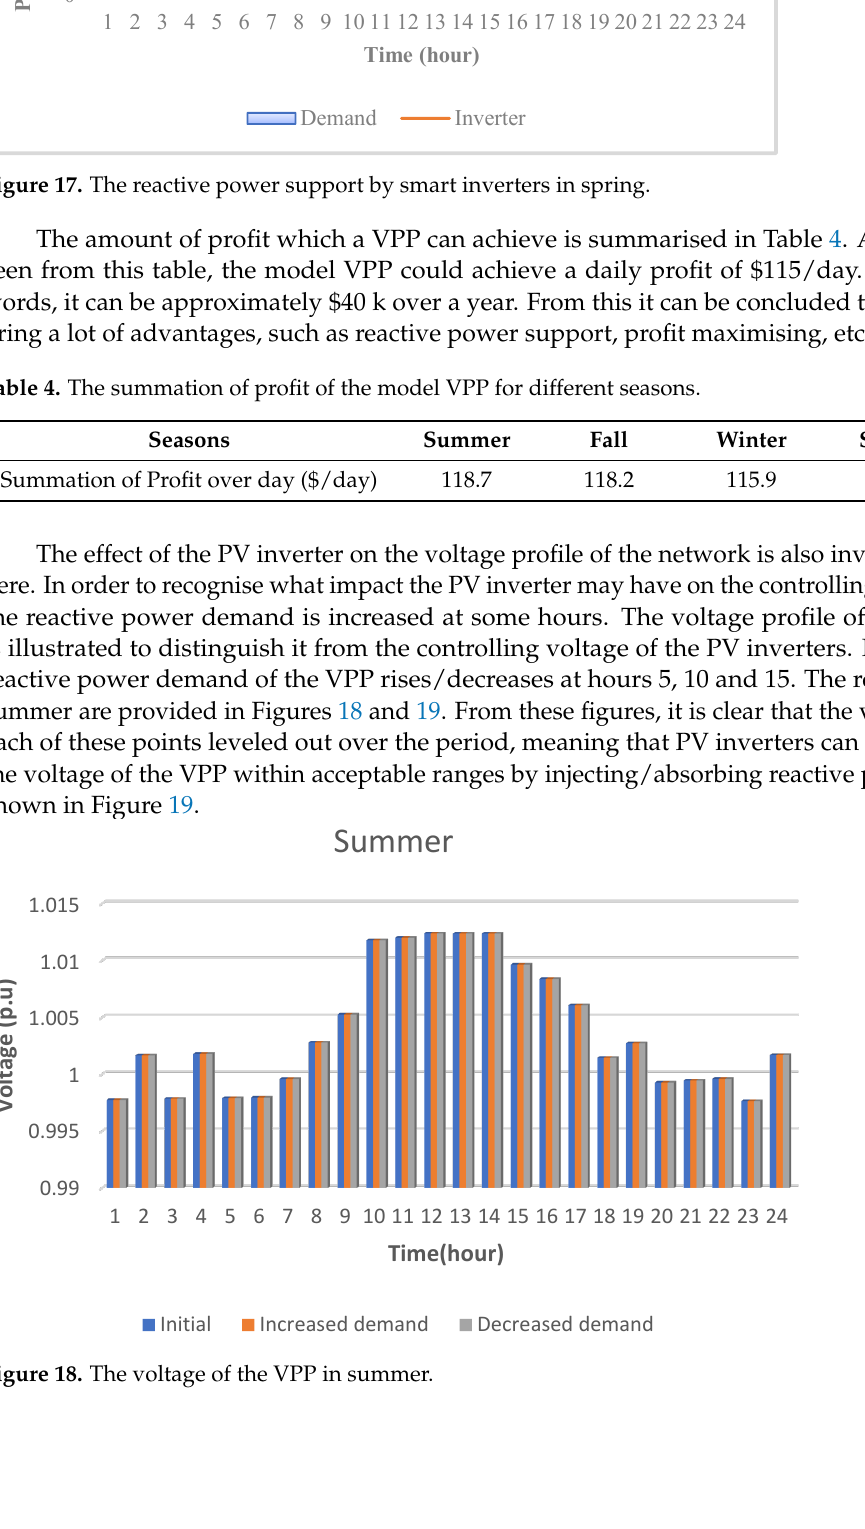
Figure 19. The reactive power provided by smart inverters in summer when demand varies. 7. Discussion and Conclusions Power systems are undergoing a revolution due to the introduction of new technol- ogies, concepts and designs. Recently, by realising the merits of VPPs, this is becoming much more appealing around the world. This paper, consequently, has provided a com- prehensive review of this emerging technology. In addition, the concept of grid-forming virtual power plants was also introduced, meaning that solar energy is integrated into the network by smart inverters. Smart inverters enable VPP operators to support the reactive power of the VPP as well as inverting the DC current to the AC form. After that, the prob- lem formulation with the aim of profit maximization for the VPPs has been developed in the presence of smart inverters. Finally, the concept was simulated for a VPP in Western Australia. From this investigation, some conclusions can be derived, as listed below: •